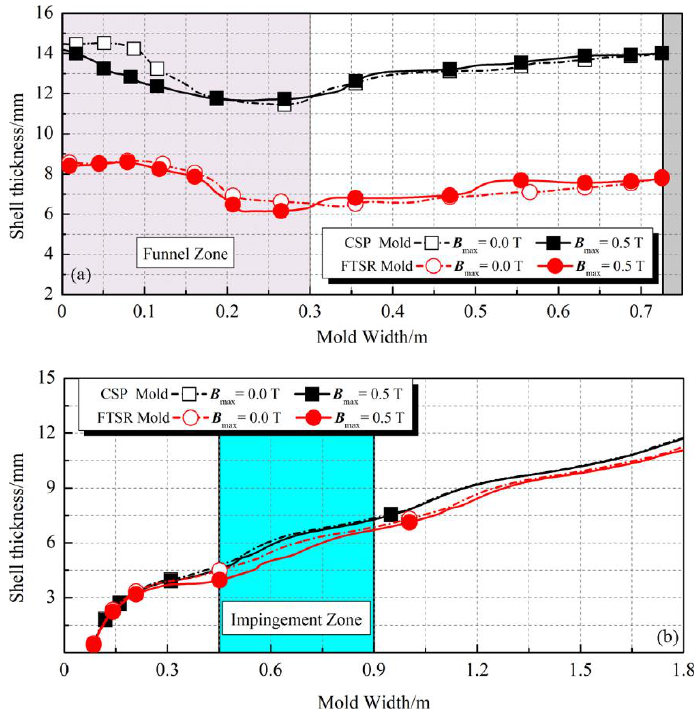
Figure 18. Effect of magnetic flux density on solidified shell thickness in the two casters: ( a ) at the mold exit on the mold wide face and ( b ) at the center line on the mold narrow face.